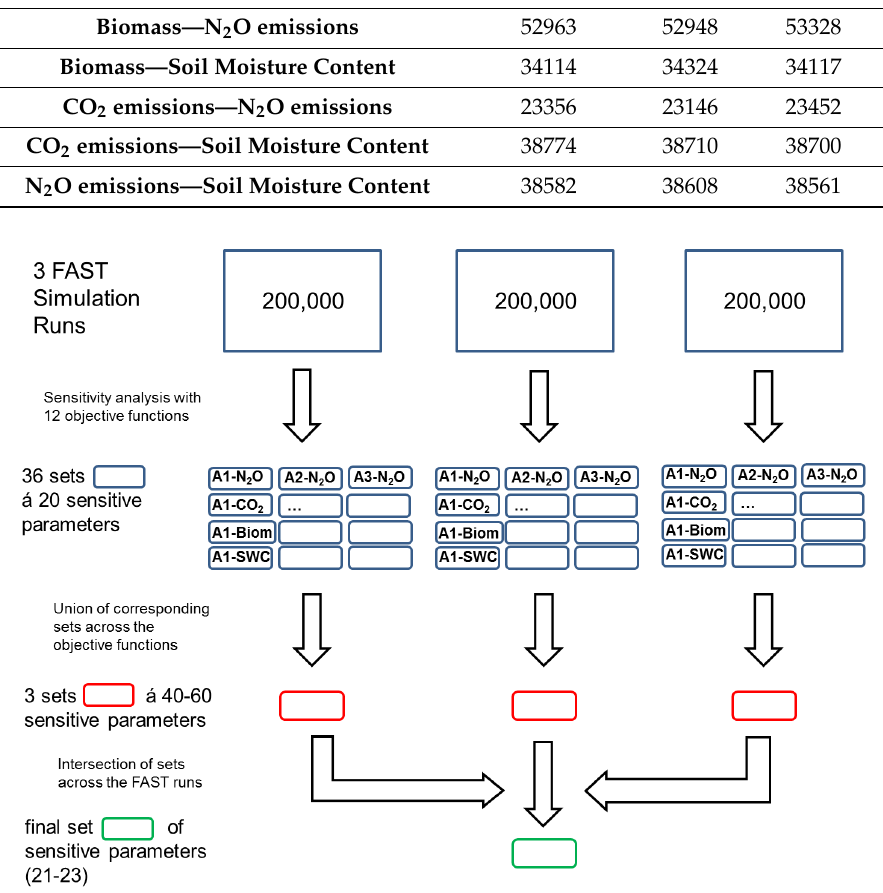
Table A5. Pair-wise partial intersection sizes for withGW simulations: the number parameter sets that belong to the best 25% simulations of two target values.